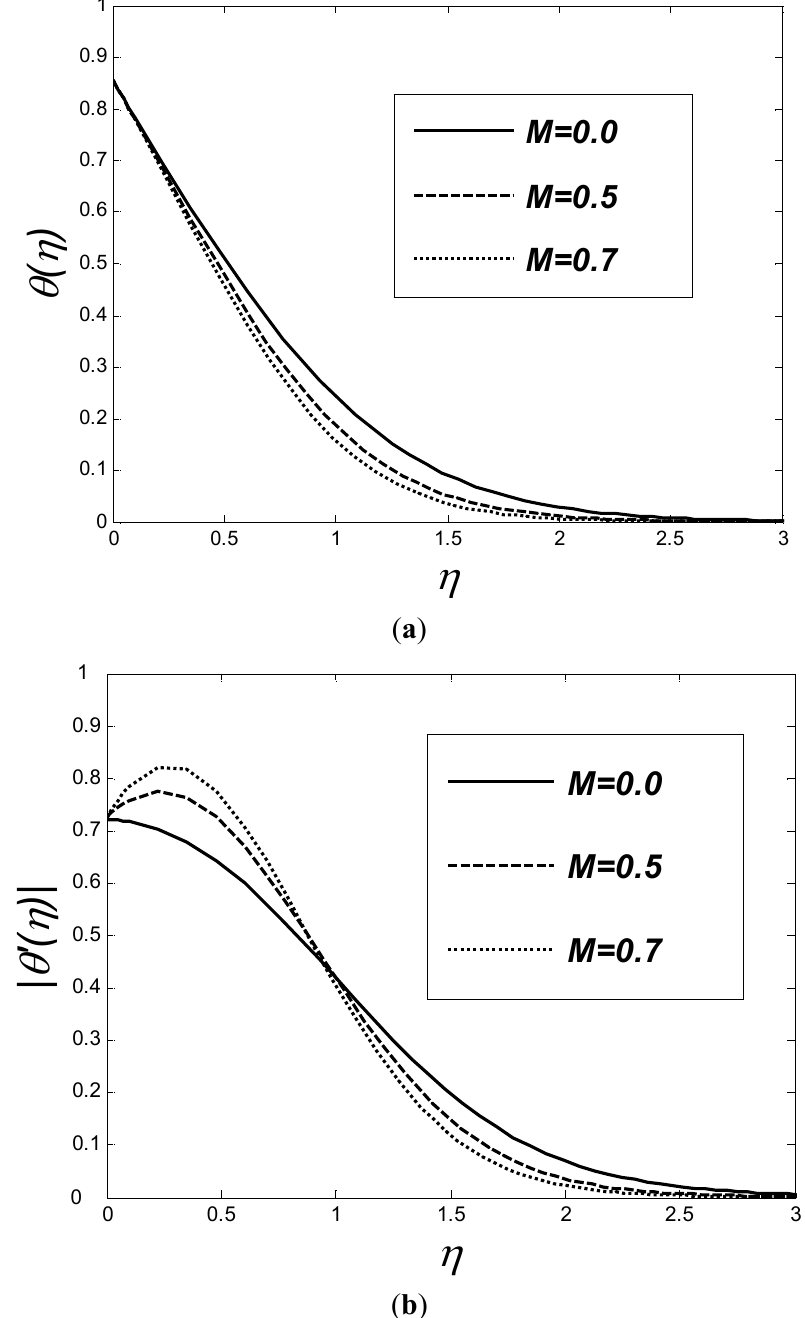
= 0.2, K = 0.5 and a = w